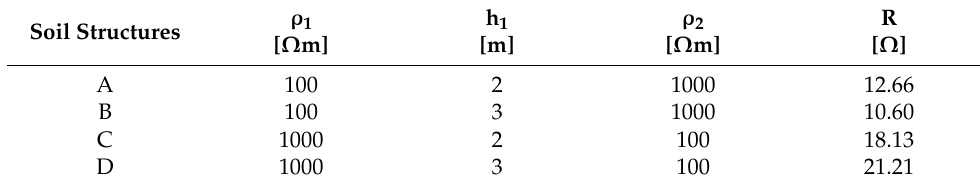
Table 1. Simulated soil